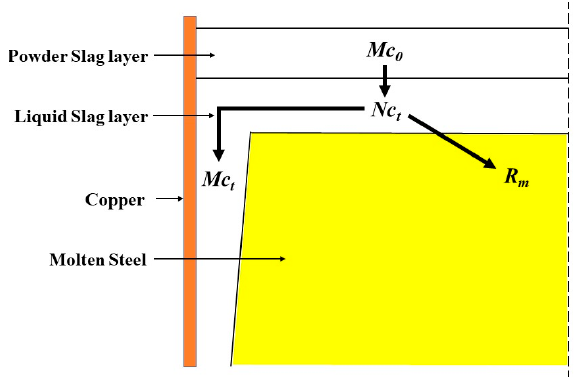
Figure 11. Kinetics equilibrium balance of SiO 2 content in liquid slag layer.